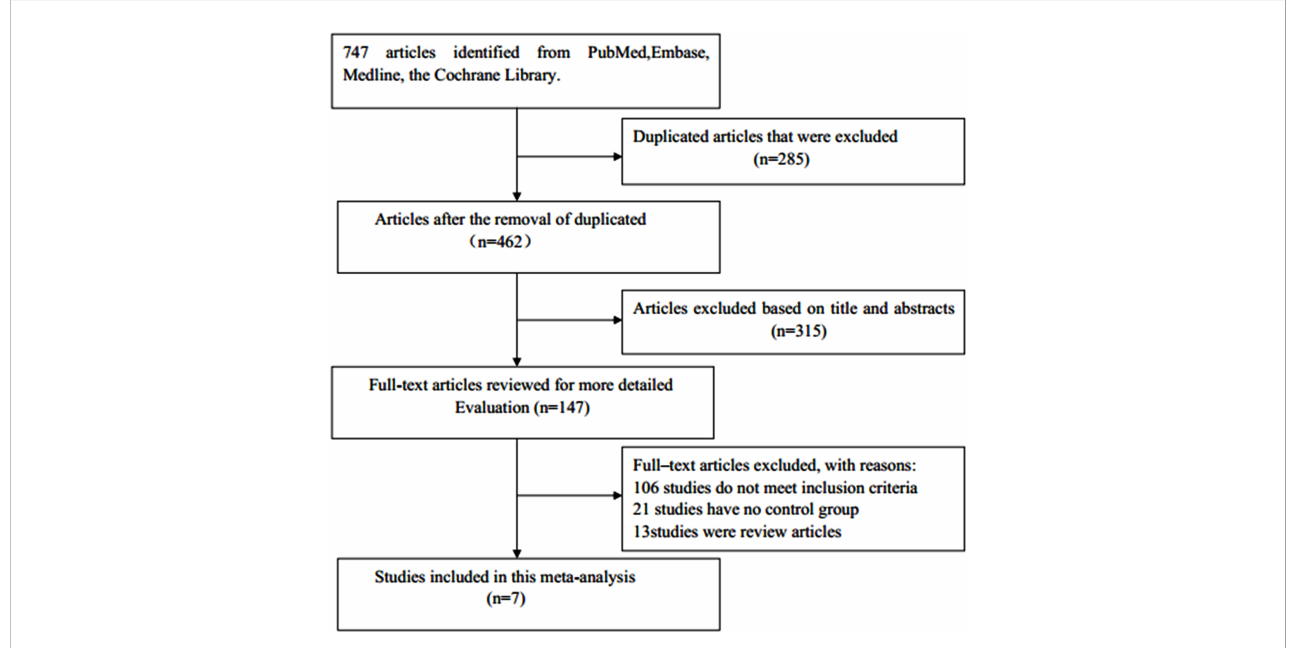
FIGURE 1 Flowchart of study